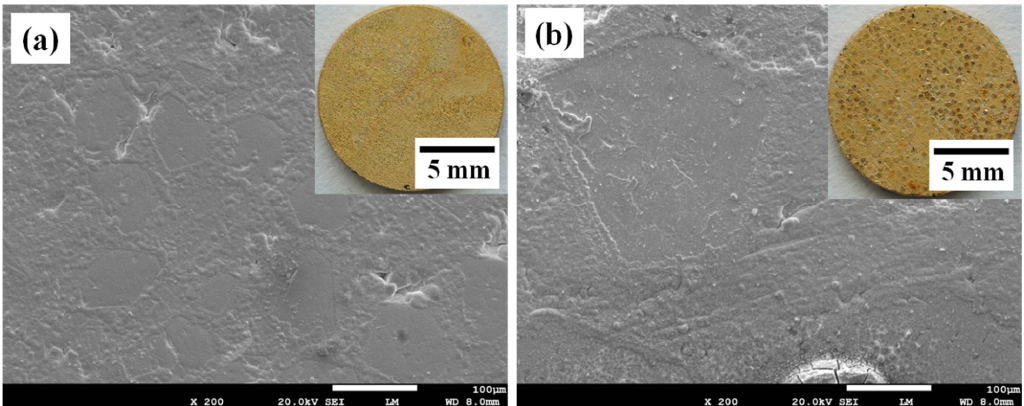
Figure 3. Optical images and SEM images of the gold-plated Diamond/Cu composites corroded